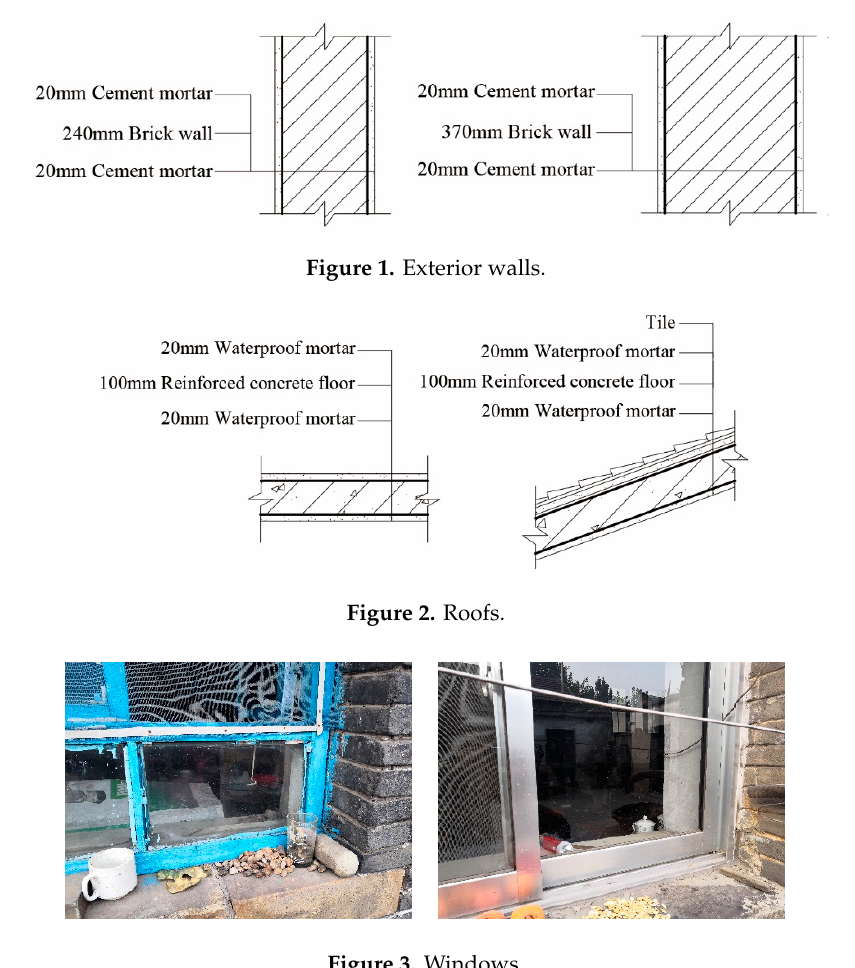
Figure 3. Windows. Figure 3.